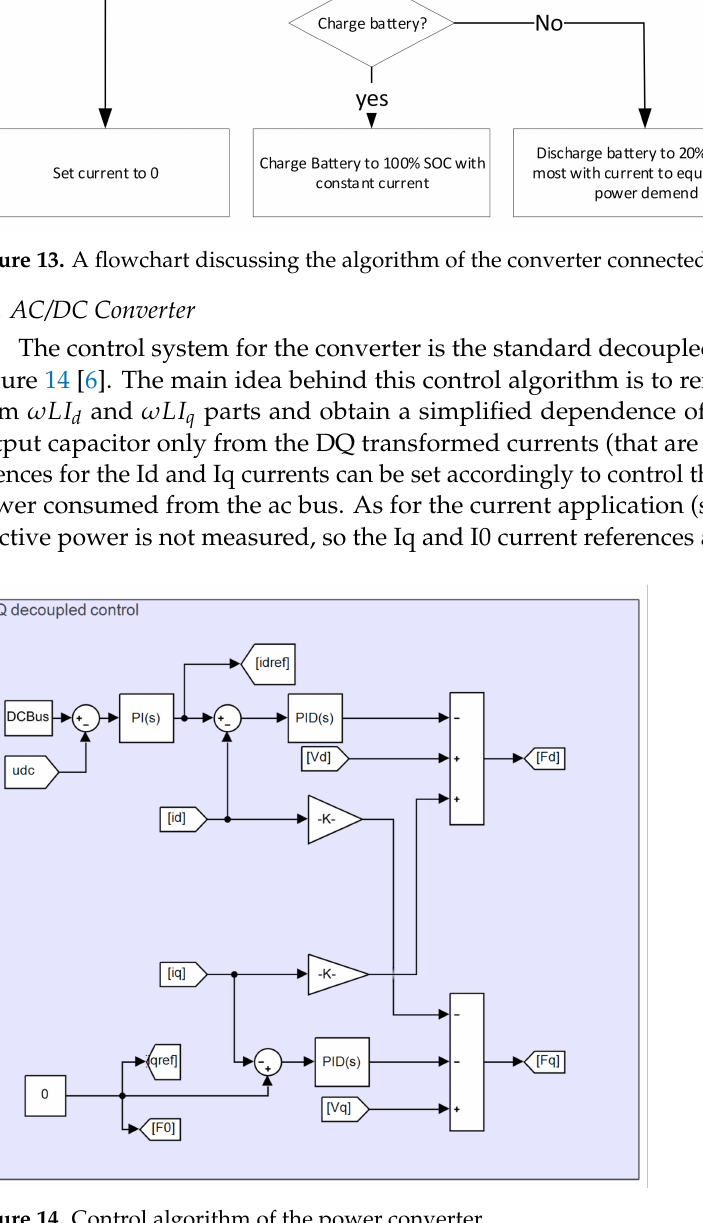
Figure 14. Control algorithm of the power